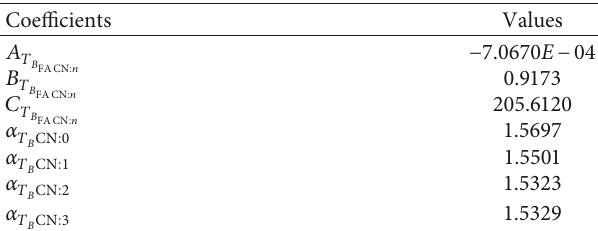
Table 6: Coefficients for the estimation of the normal boiling point according to equation (13).